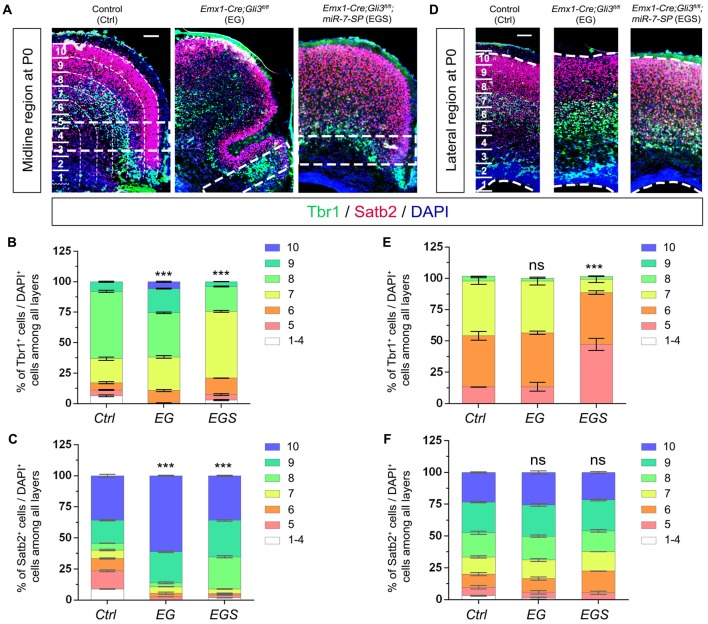
The regulatory role of Gli3 and miR-7 in modulating neuronal migration in the P0 cortex. (A–C) Absence of Gli3 facilitated more Tbr1+ and Satb2+ marked neurons to migrate into the upper bins in the midline region, while double-lose of miR-7 and Gli3 partially corrected the migratory process. (D–F) Subtle alteration of migratory process was detected in the upper bins in the cortical lateral region in EG and EGS brains. The markers Tbr1, Satb2 and DAPI stained for deeper bin newborn neurons, upper-bin newborn neurons and all cells, respectively. Values represent mean ± SEM. n > 9. ***P < 0.001; ns, not significant. One-way ANOVA with post hoc test was used. Scale bar = 100 μm.